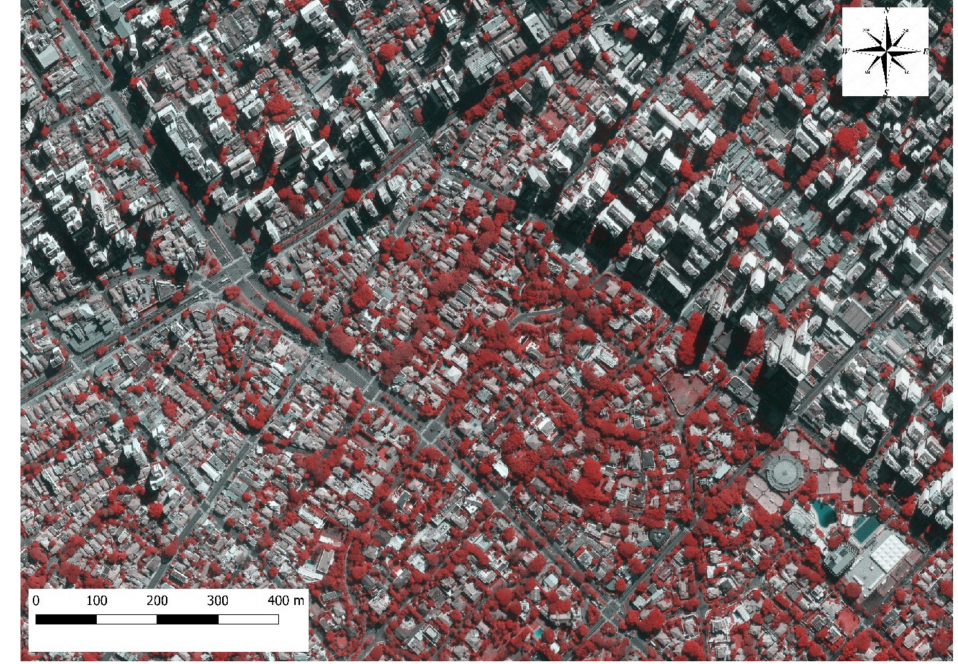
Figure 2. Sample of the orthophoto (2-m spatial resolution) of S ã o Paulo with the near infrared band of QGIS2.18.11, showing green areas in shades of